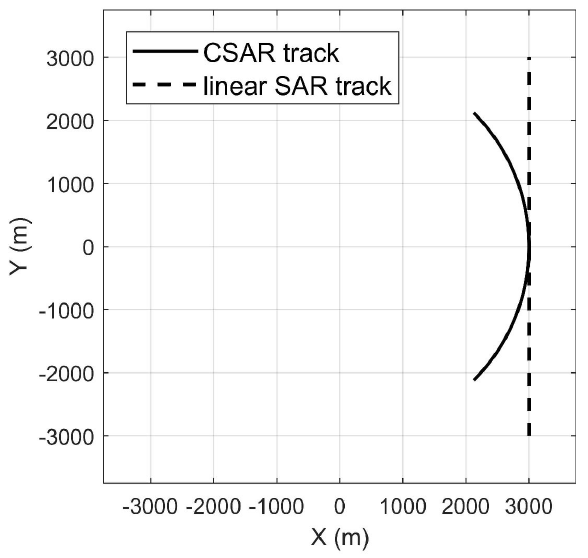
Figure 24. The top view of the geometry for